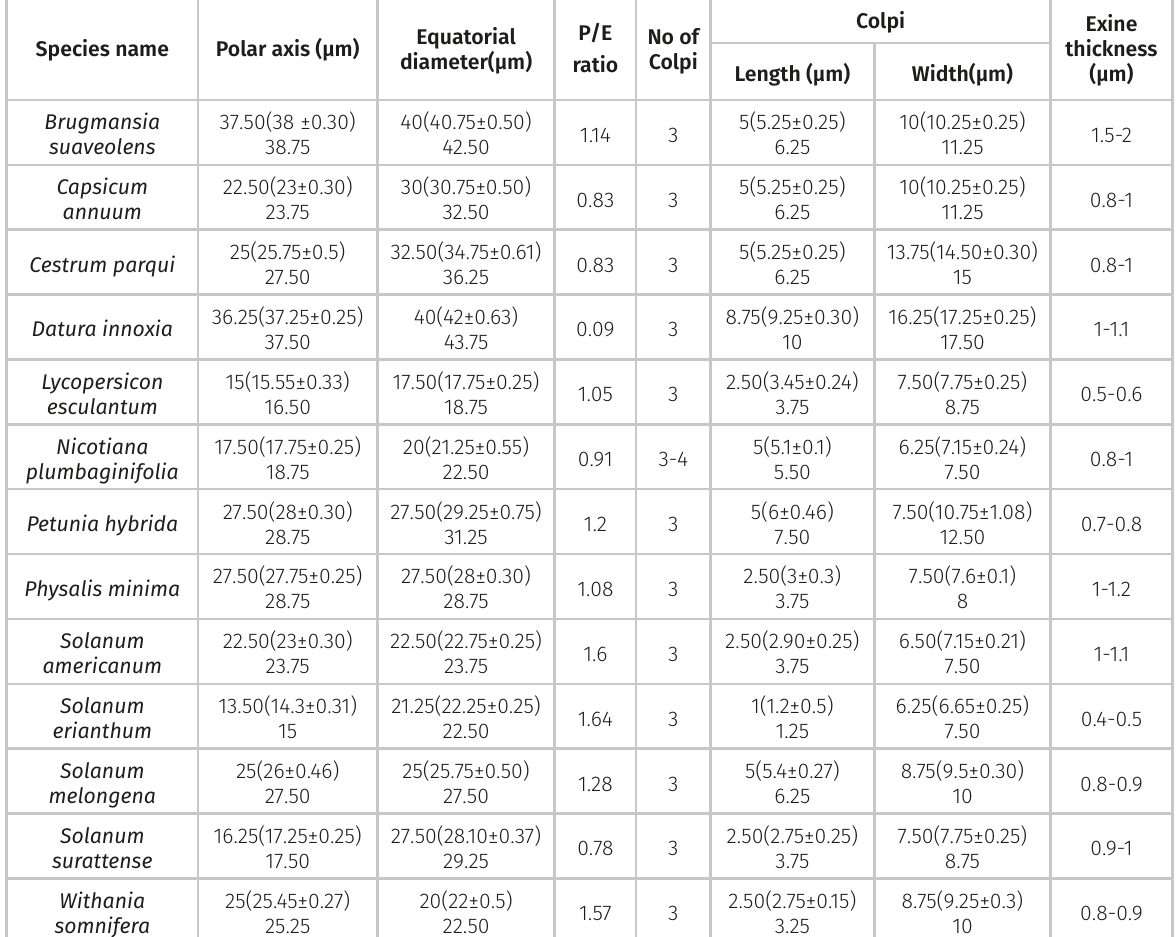
Table II. Quantitative data for the pollen of Solanaceous